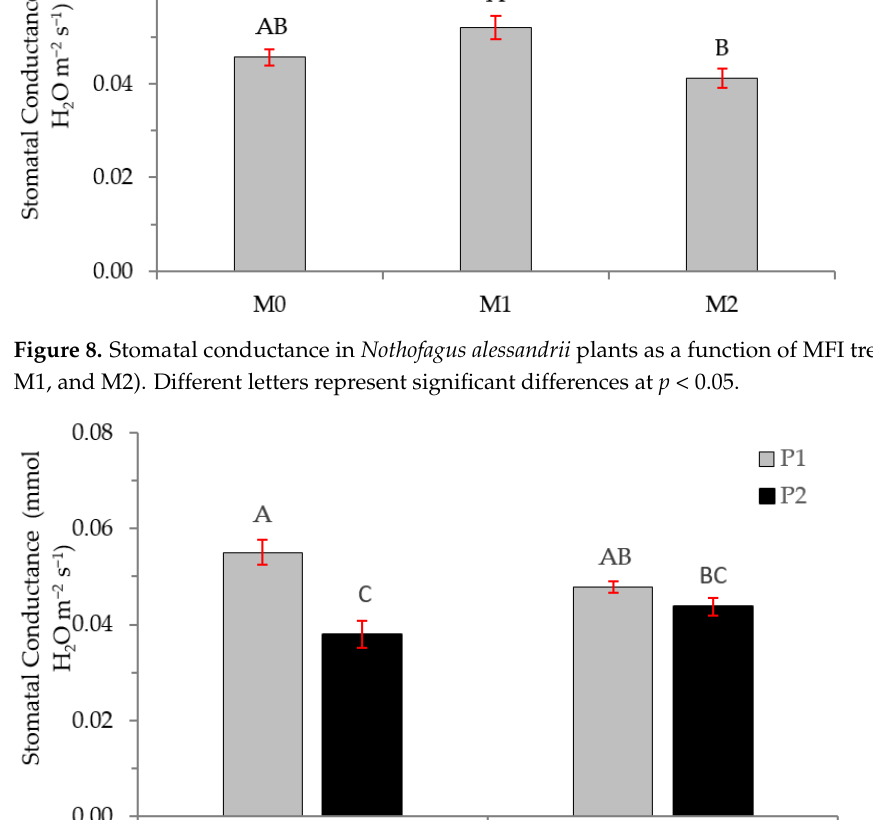
Figure 9. Stomatal conductance in Nothofagus alessandrii plants as a function of fertilization (F1 and F2) and plant type (P1 and P2). Different letters represent significant differences at p < 0.05.